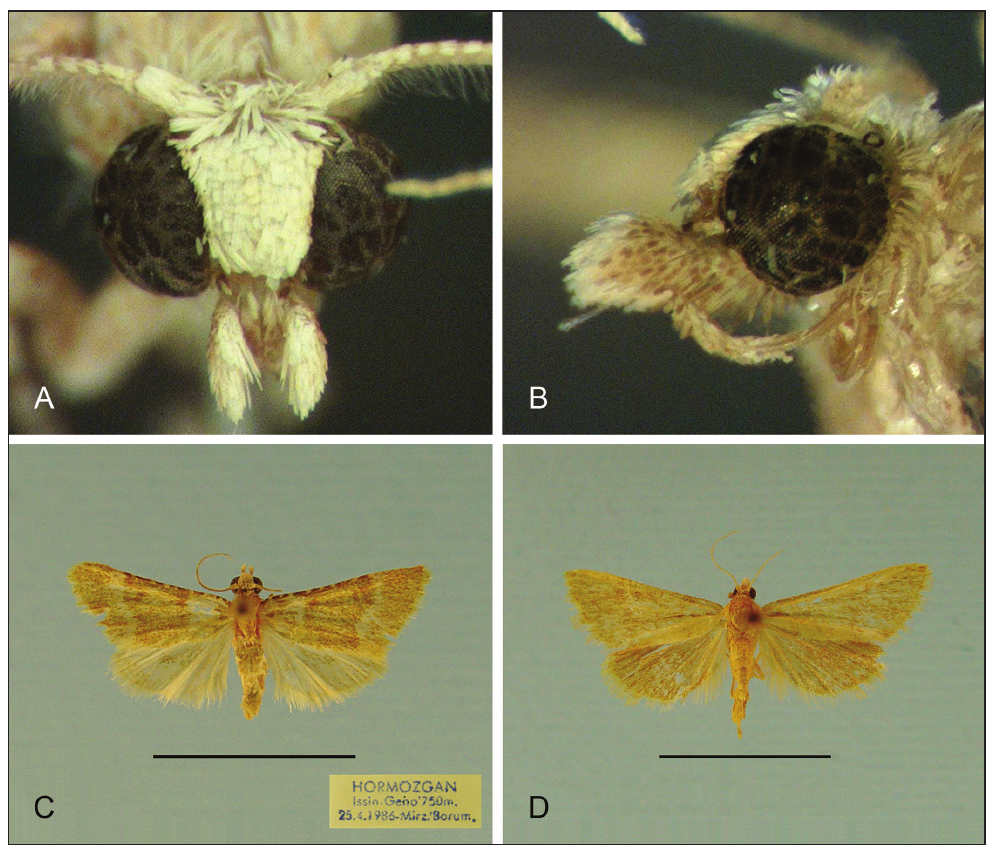
Figure 1. Acteniopsis gambronensis sp. n. head and adult male ( A–C ), and A. kurdistanella Amsel, adult female ( D ). A ) head in frontal view, B ) head in lateral view, C ) adult male (Holotype, Iran, Hormozgan Prov., Isin). Scale bars: 1